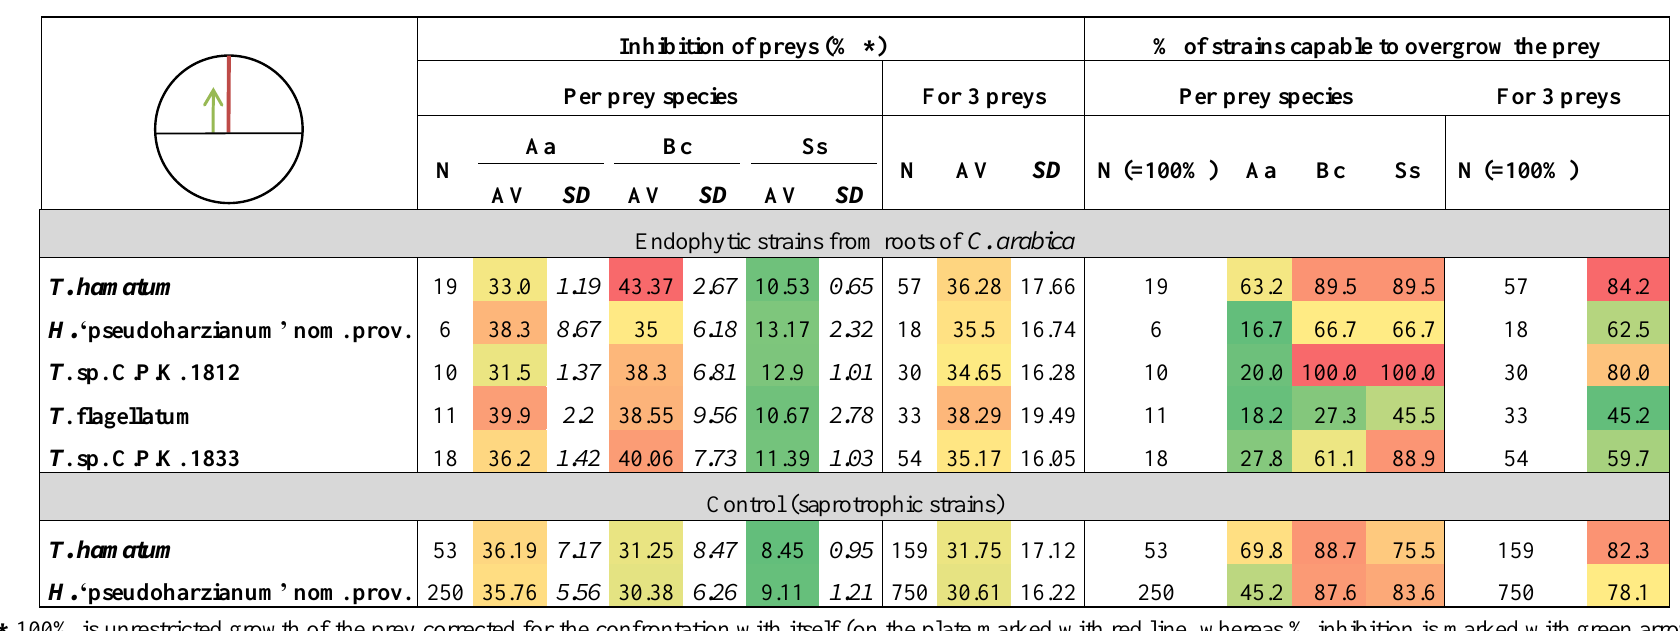
Table 3. Antagonistic potential (plant pathogen‘s growth inhibition and overgrowth) of endophytic Trichoderma strains isolated from C. arabica roots and their comparison to saprotrophic T. hamatum and H. ‗pseudoharzianum‘ nom.